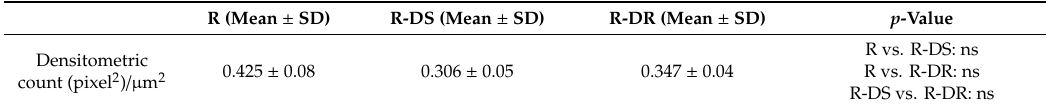
Figure 7. Vitamin D receptor (VDR) immunohistochemical evaluation in the articular cartilage through computerised densitometric measurements and image analysis. ( A ) R group; ( B ) R-DS group. ( C ) R-DR group. In inserts are the image analyses by the software in which the red colour represents brown staining (immune complexes labelled with chromogen). For details, see the text. ( A – C ) Objective lens, 10; scale bars: 100 µ m. These are the most representative images of articular cartilage from rats of each group (R, R-DS and R-DR). Table 8. VDR Immunostaining—Articular